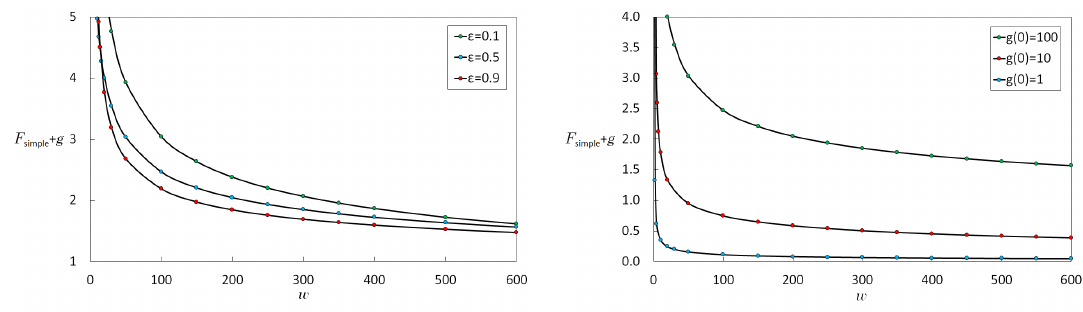
Figure 11. Dependence of the majorant F simple + g on the width of the coupling constant w for different values of the parameters ε and the amplitude of the coupling constant g ( 0 ) . ( Left ) g ( 0 ) = 100. ( Right ) ε = 0.5.